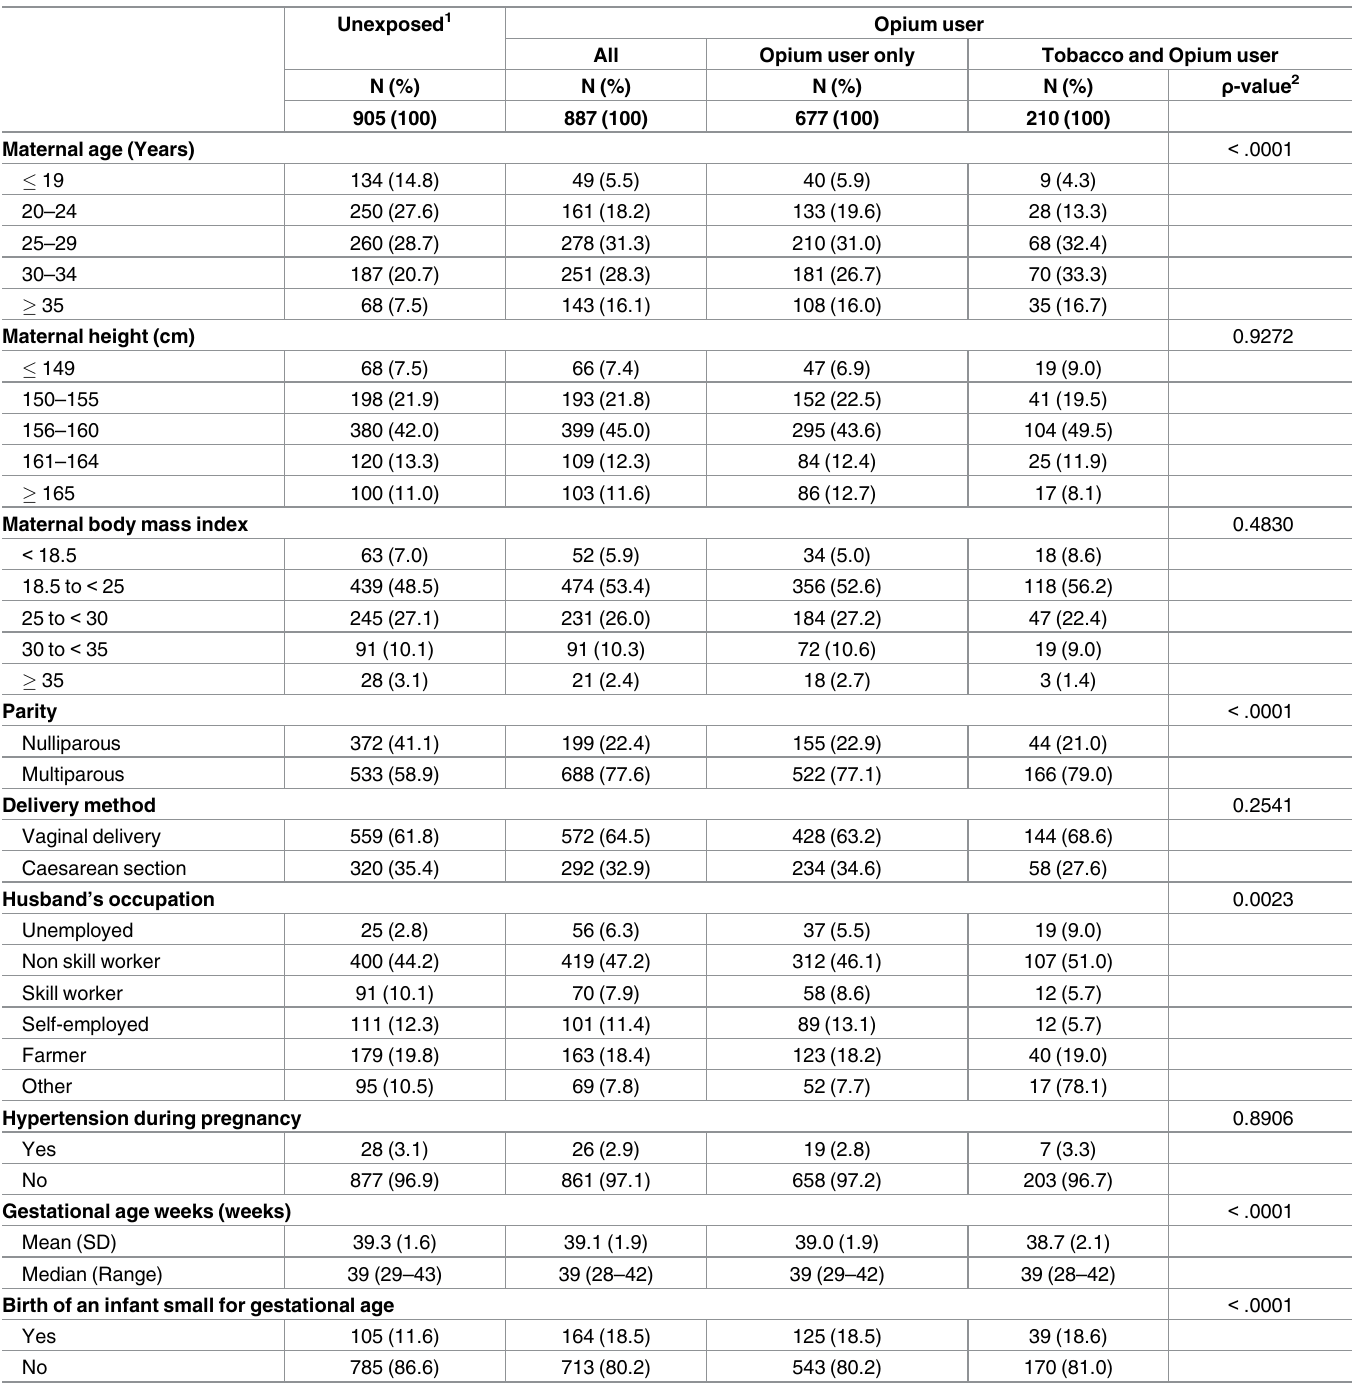
Table 1. Characteristics of study